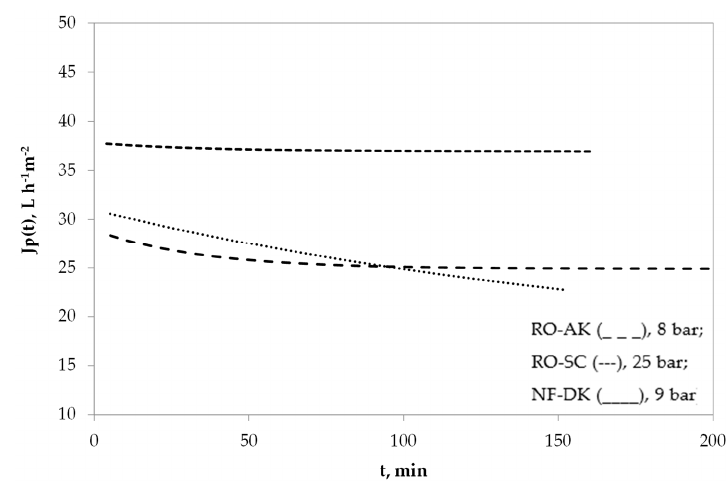
Figure 2. Experimental vs boundary-flux-modelled dynamic permeate flux (J p (t), L · h − 1 · m − 2 ) of the three membranes tested. Operating conditions: 22 °C, 5.1 m/s, VRF ≥ 90%.